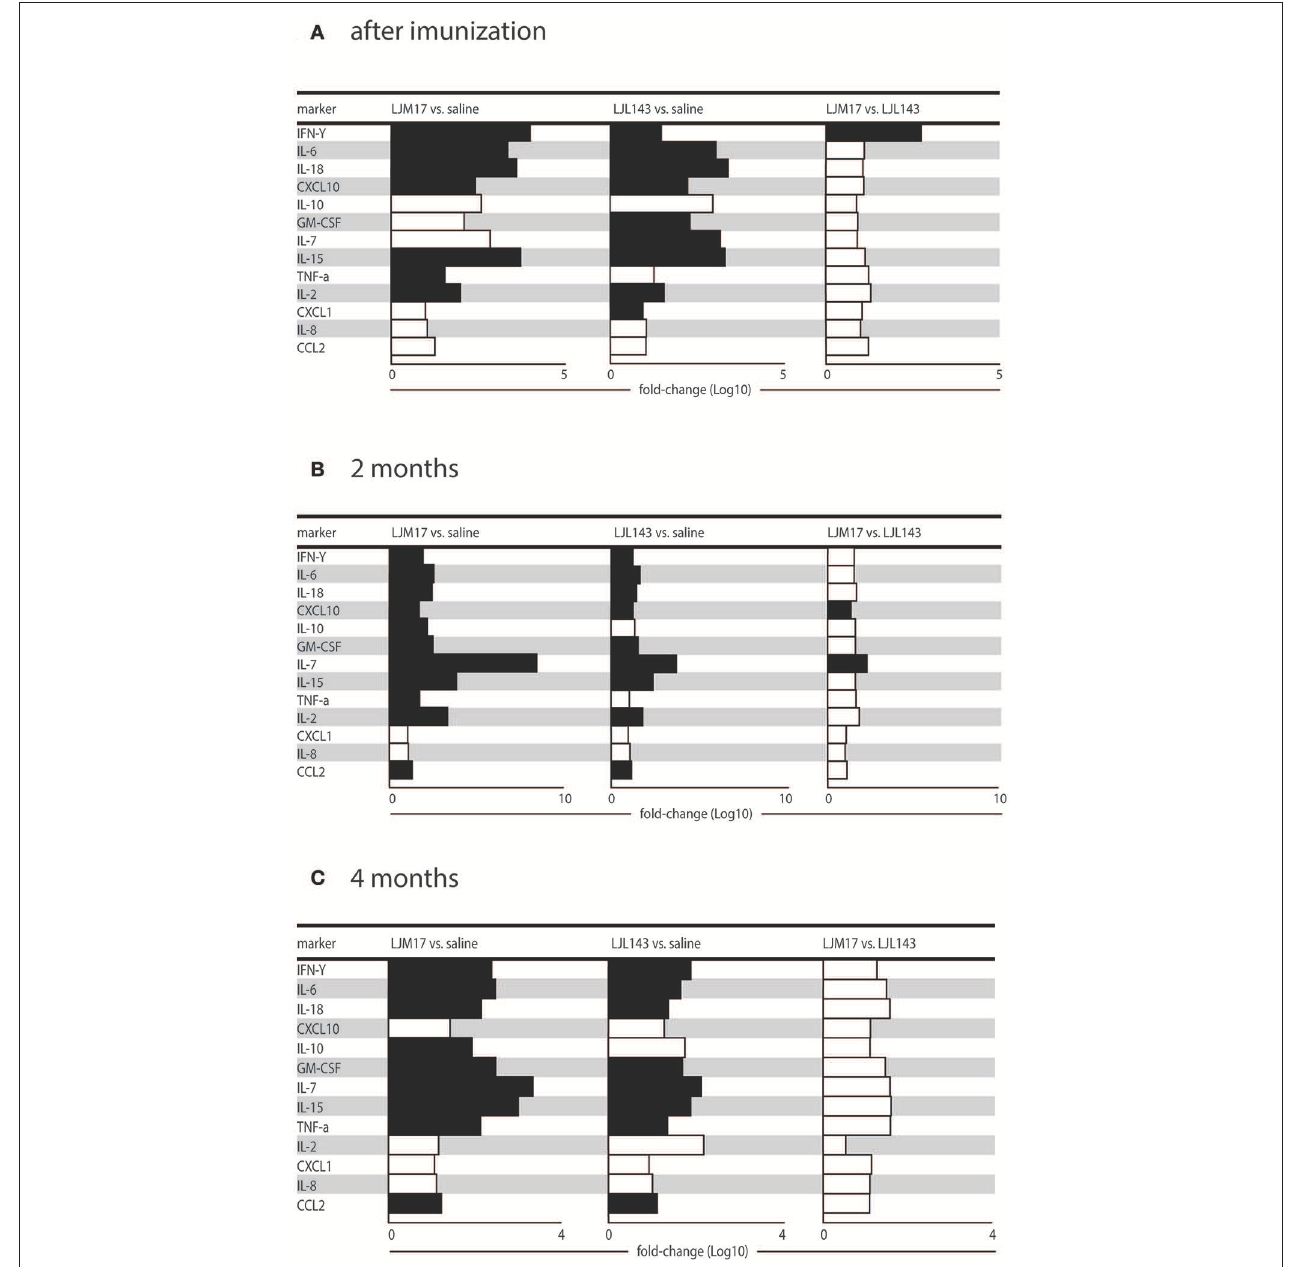
FIGURE 4 | Cytokine and chemokine expression profiles in immunized dogs and controls. Beagle dogs ( n = 10 animals/group; total of 30 dogs) were immunized following the vaccination strategies described in the methodology section. Thirty days after the final immunization, dogs were challenged with L. infantum in the presence of L. longipalpis saliva. Immunized and control animal sera were collected at T0 (15 days after immunization), T1 and T2 (2 and 4months after infection) to detect cytokines and chemokines in the sera. (A) Cytokines and chemokines 15 days after immunization, (B) cytokines and chemokines 2 months after infection and (C) cytokines and chemokines 4 months after